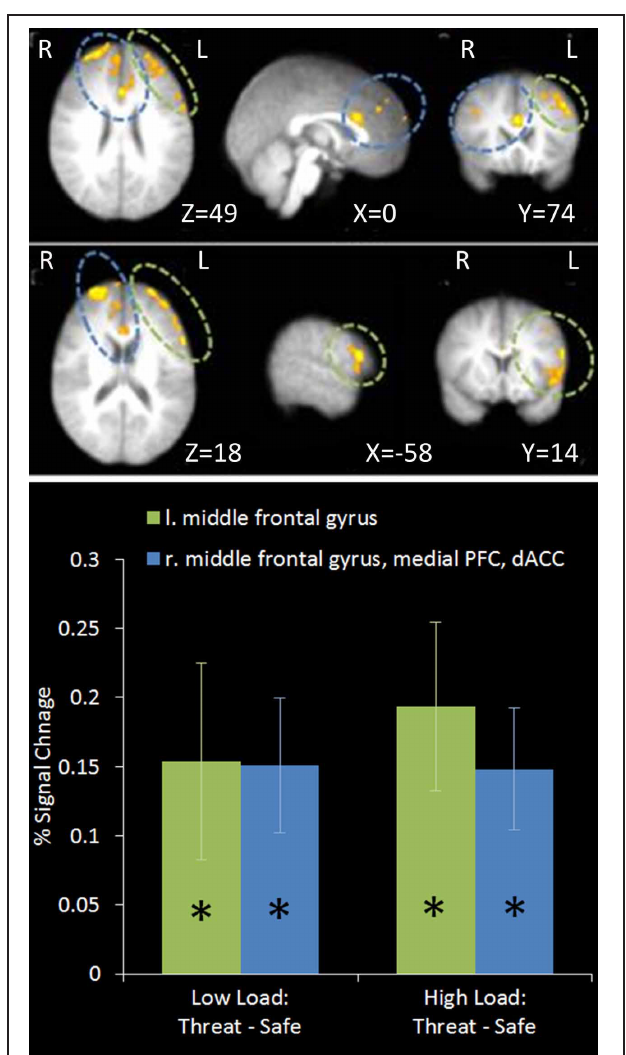
FIGURE 4 | Top: Threat—Safety contrast imaging results. Two significant clusters were identified revealing significant bilateral middle frontal gyrus, medial PFC and dACC activation under Threat compared to Safe conditions. Bottom: Pairwise comparisons of the signal change in the clusters identified. Activation in both clusters was significantly greater under Threat than Safety at both Low and High Load [left middle frontal gyrus: Low Load/Threat—Low Load/Safe: mean difference = 0.153%, S . D = 0 . 213, t ( 17 ) = 3 . 043, p = 0 . 007; High Load/Threat—High Load/Safe: mean difference = 0.192%, S . D = 0 . 183, t ( 17 ) = 4 . 468, p < 0 . 001; right middle frontal gyrus, medial PFC and dACC cluster: Low Load/Threat—Low Load/Safe: mean difference = 0.149%, S . D = 0 . 146, t ( 17 ) = 4 . 335, p < 0 . 001; High Load/Threat—High Load/Safe: mean difference = 0.147%, S . D = 0 . 132, t ( 17 ) = 4 . 729, p < 0 . 001]. Error bars display within-subject standard error (Morey, 2008). ∗ p < 0 . 05